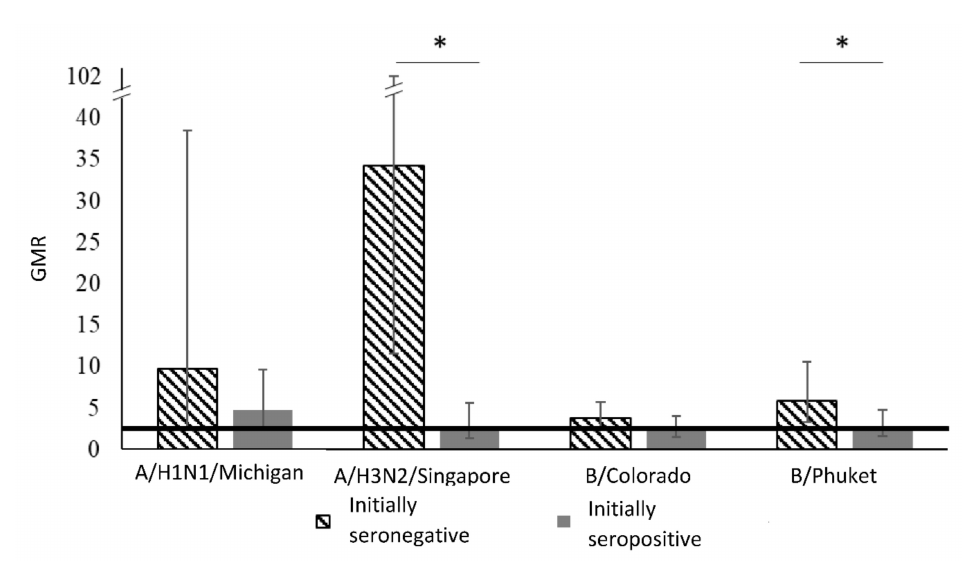
Figure 3. GMR given the initial level of antibodies in the group of healthy participants. Notes: *—statistically significant differences between